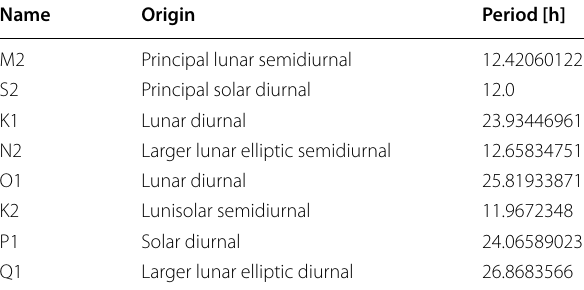
Table 1 Tidal constituents used within the KALMAG